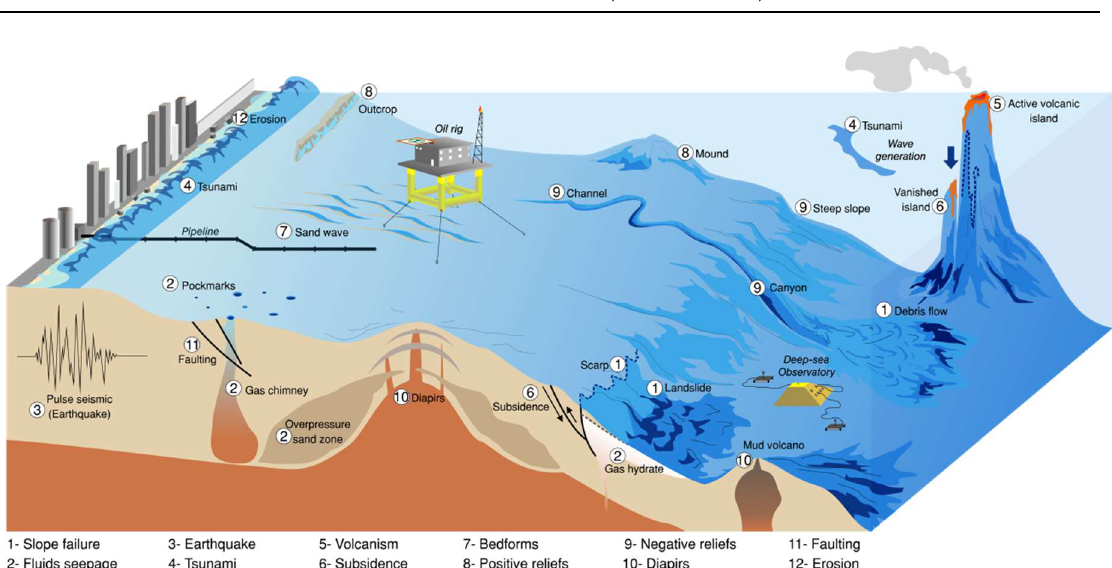
Figure 16. Categories of marine geohazards defined after the grouping of features, process, and related events with similar nature.